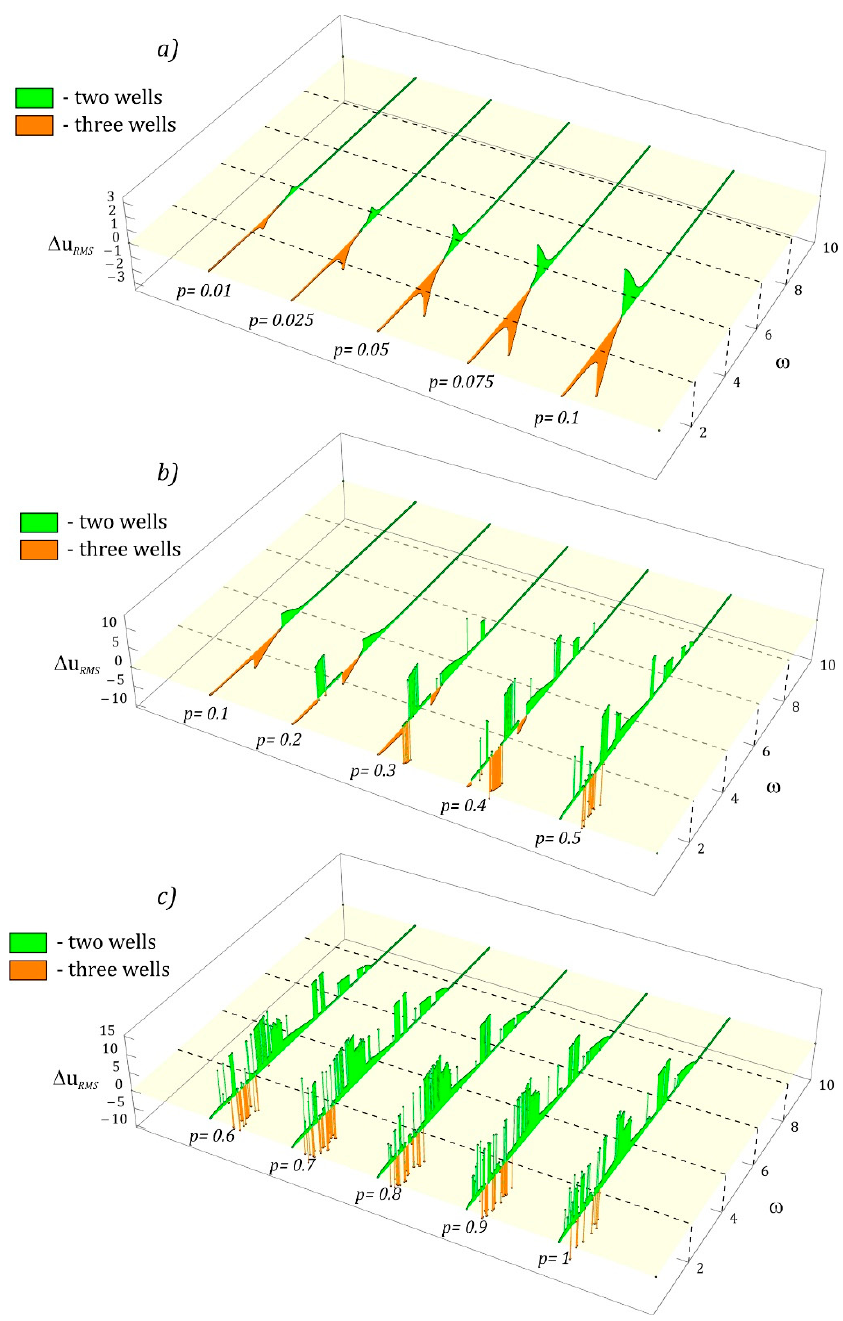
Figure 12. Comparison of RMS voltage outputs for two- and three-well potential systems versus amplitude and frequency. ω is dimensionless, while U RMS is expressed in Volts.